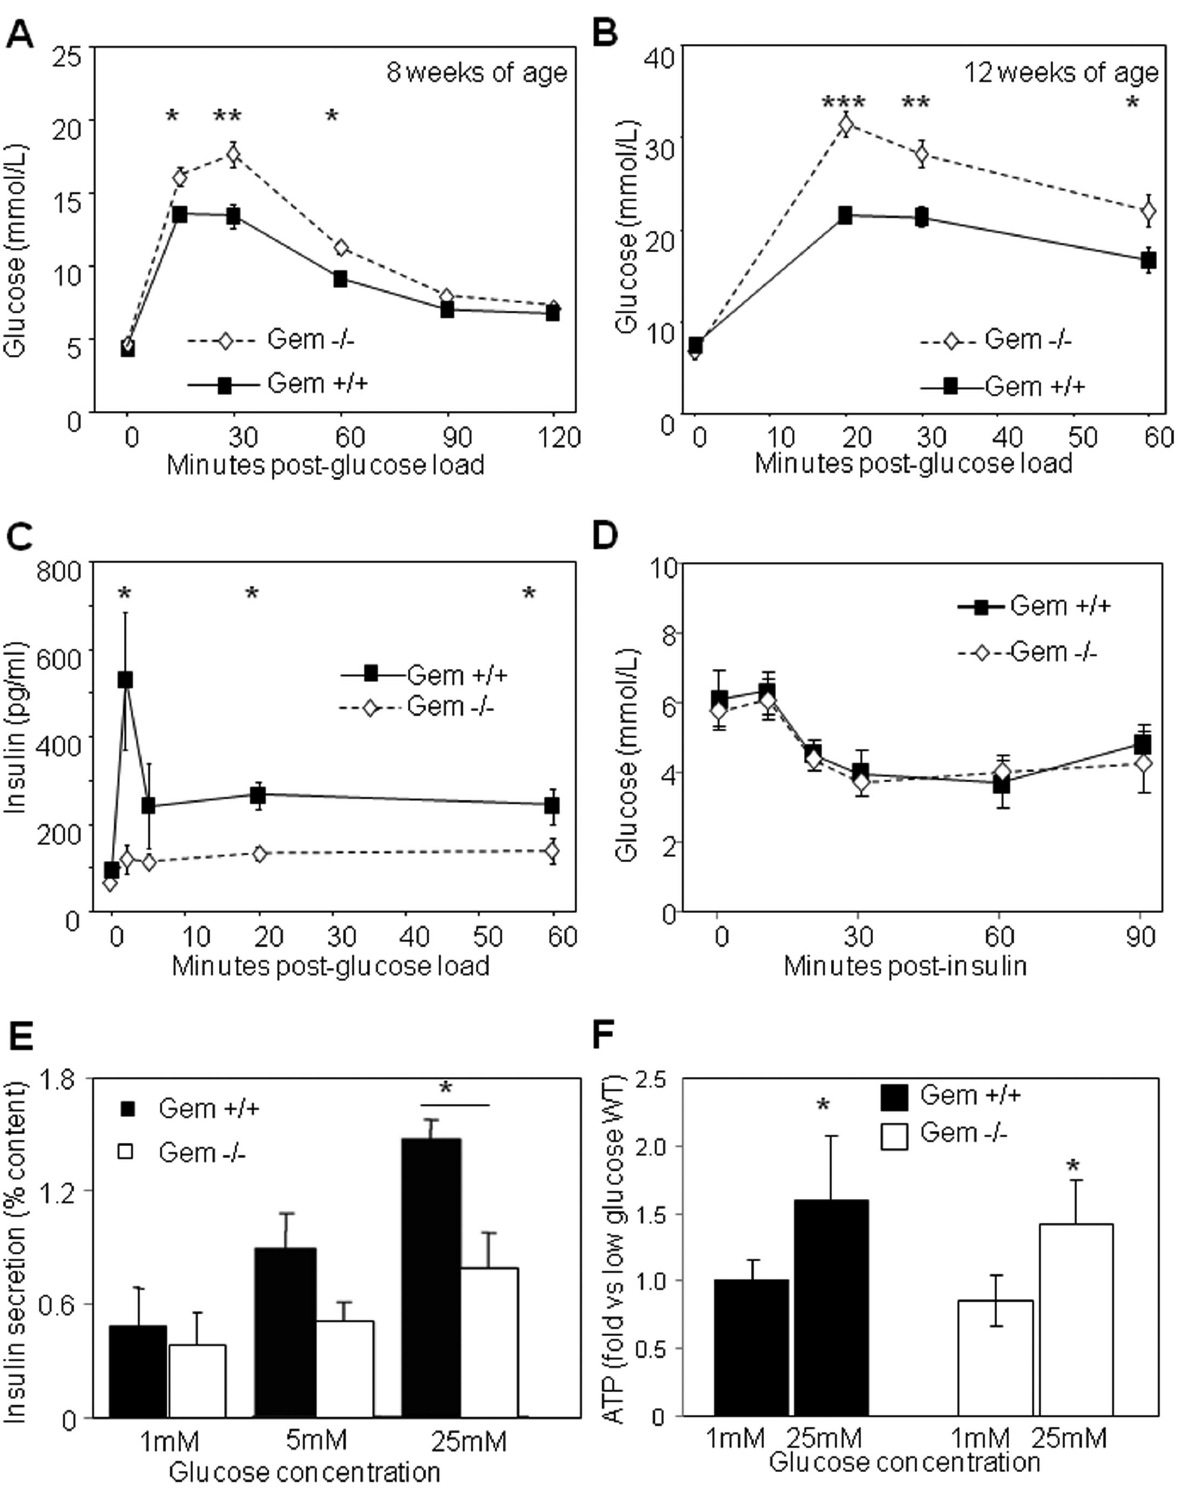
Figure 2. Gem-deficient mice were glucose intolerant. A ) Eight (8) week old Gem 2 / 2 mice had impaired glucose homeostasis on glucose tolerance testing (GTT). B ) Glucose tolerance was also significantly worse in 12 week old Gem 2 / 2 mice. C ) Glucose stimulated insulin secretion in vivo was impaired in Gem 2 / 2 mice. D ) Whole body insulin sensitivity was un-altered in Gem 2 / 2 mice, as indicated by insulin tolerance tests. E ) Insulin release in isolated islets was impaired in Gem 2 / 2 mice. F ) Glucose stimulated increase in ATP content was normal in Gem 2 / 2 mice. Error bars indicate 6 1SEM. *=p , 0.05, **=p , 0.01, ***=p , 0.001.